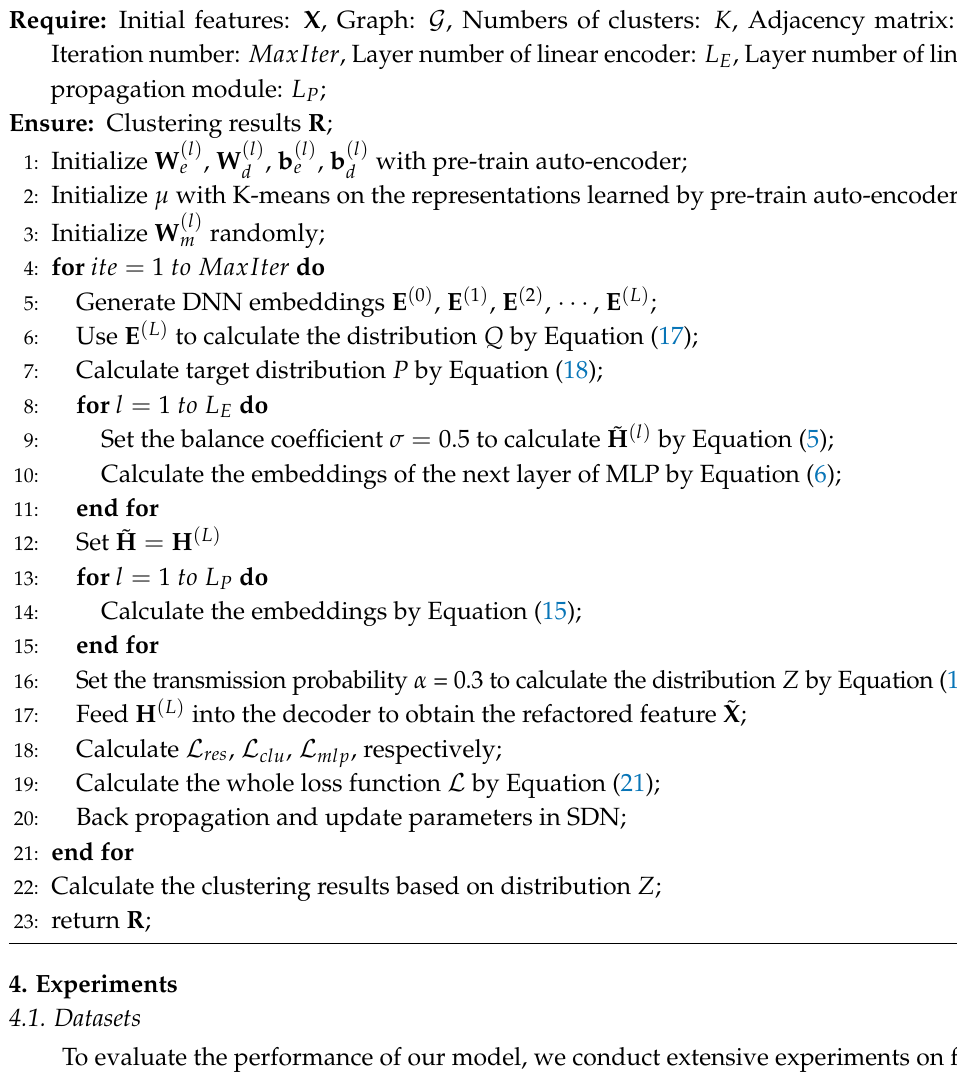
Algorithm 1 Training process of